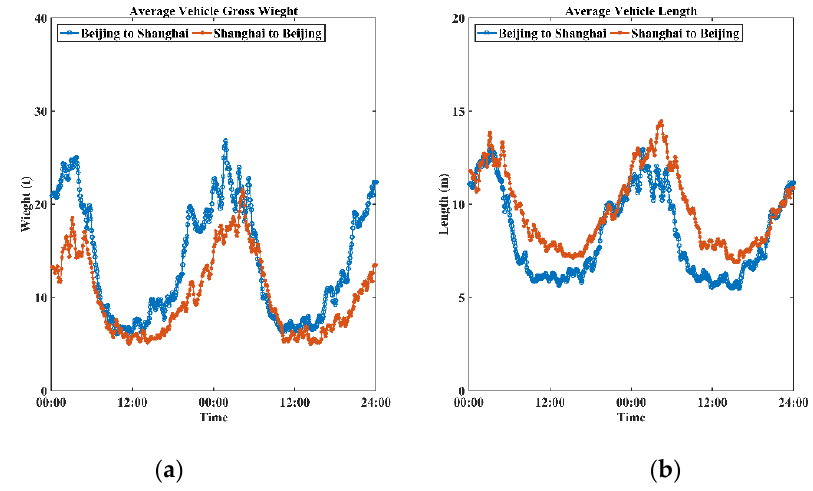
Figure 7. Demonstrations of average vehicle gross weight ( a ) and length ( b ) over time.